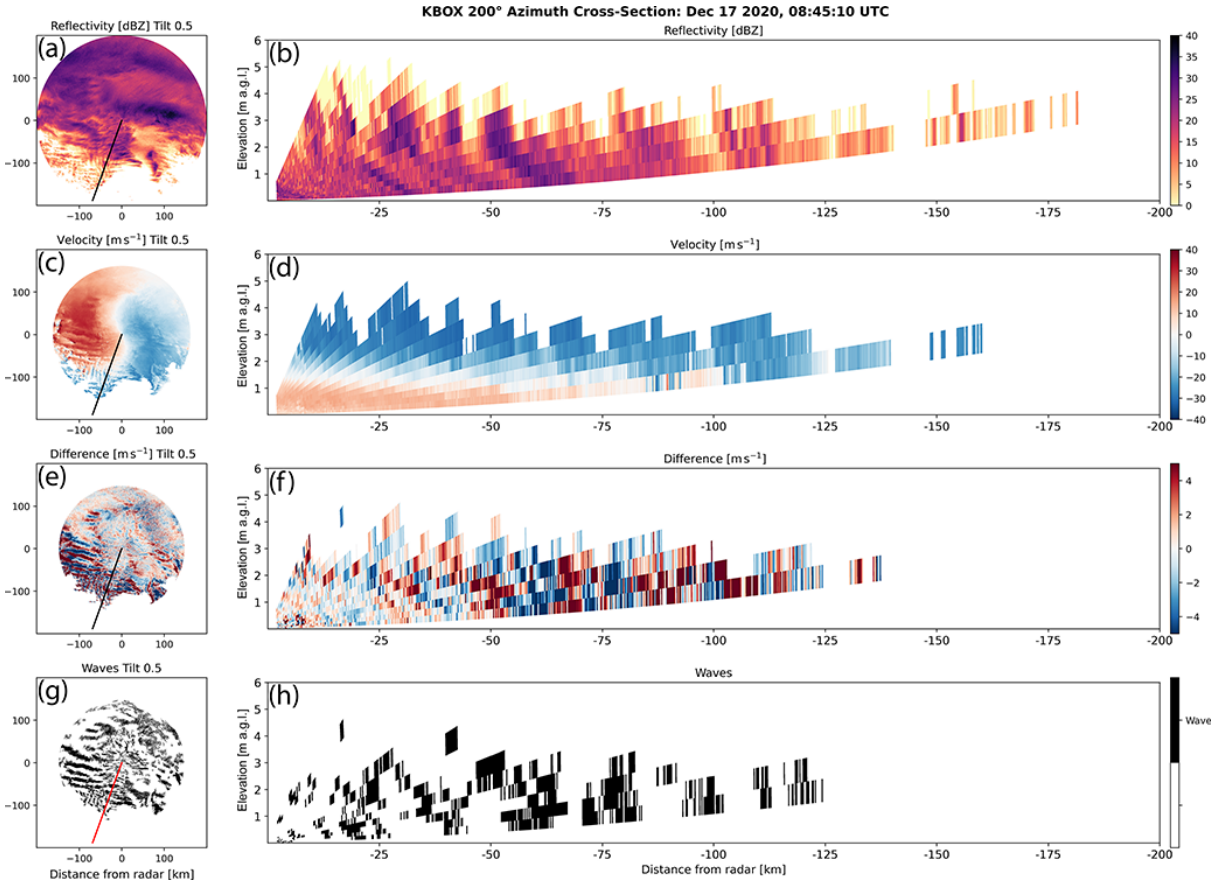
Figure 7. PPIs (a, c, e, g) and RHIs (b, d, f, h) constructed from PPI scans of reflectivity, radial velocity, the difference of radial velocity for successive scans, and the wave detection field for data from the KBOX WSR-88D radar near Boston, MA, at 08:45UTC on 17 December 2020. The RHIs are constructed from data on the 200 ◦ azimuth as denoted by the radial line on the PPI panels. An animated version of this figure is in Video Supplement Animation-Figure-7.